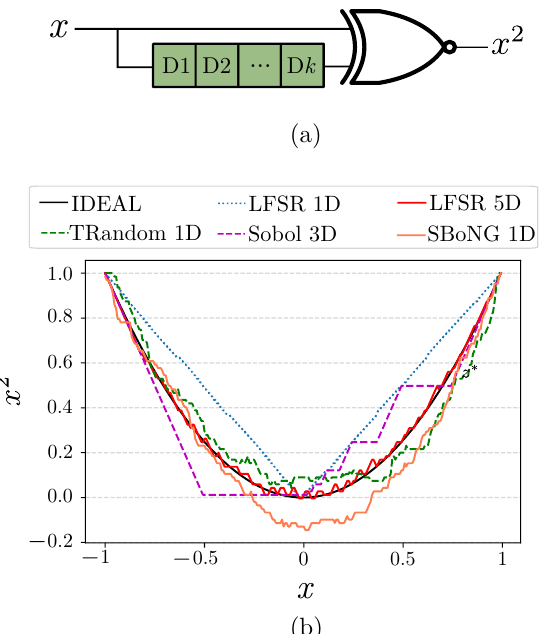
Figure 9. Bipolar Stochastic Quadratic Function (SQF). The circuit implementation is shown in ( a ) for different k DFF. The operation outcome comparison is shown in ( b ) for different RNGs: LFSR, Sobol, SBoNG, and TRNG (TRandom).